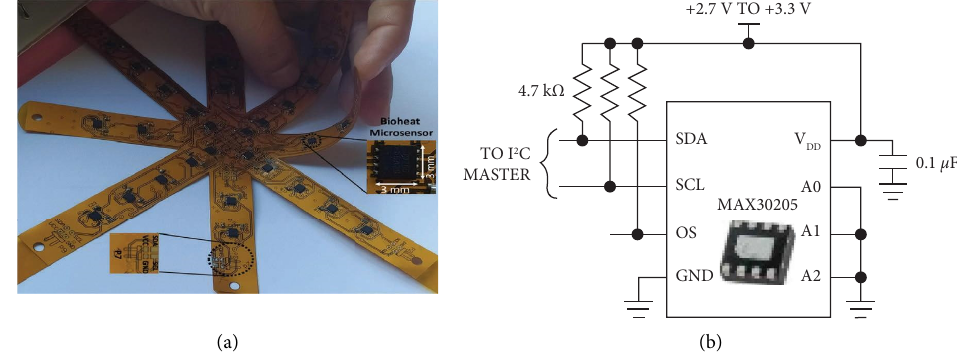
Figure 3: Photographs of bioheat microsensors network (a) Flexible card with a bioheat microsensors network and (b) Used bioheat microsensors.